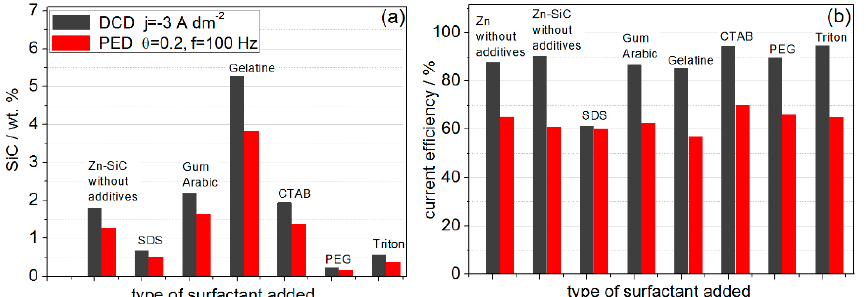
Figure 5. The effect of the type of organic additive on ( a ) the SiC content in Zn–SiC deposit, and ( b ) the faradaic efficiency of the direct current deposition (DCD) process ( j = − 3.0 A · dm − 2 ) compared with the result of the PED ( j avg = − 3.0 A · dm − 2 , θ = 0.2, f = 100 Hz).